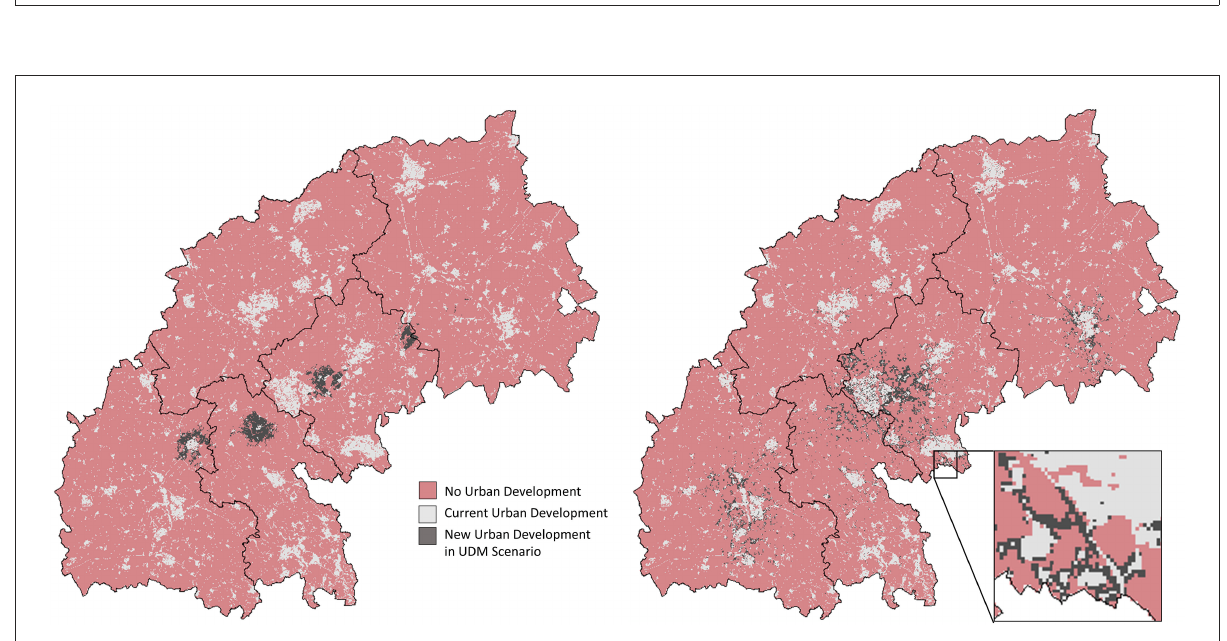
FIGURE3 Two development scenarios investigated by the study: 23-G-E (left) , 30-Y-N (right) .